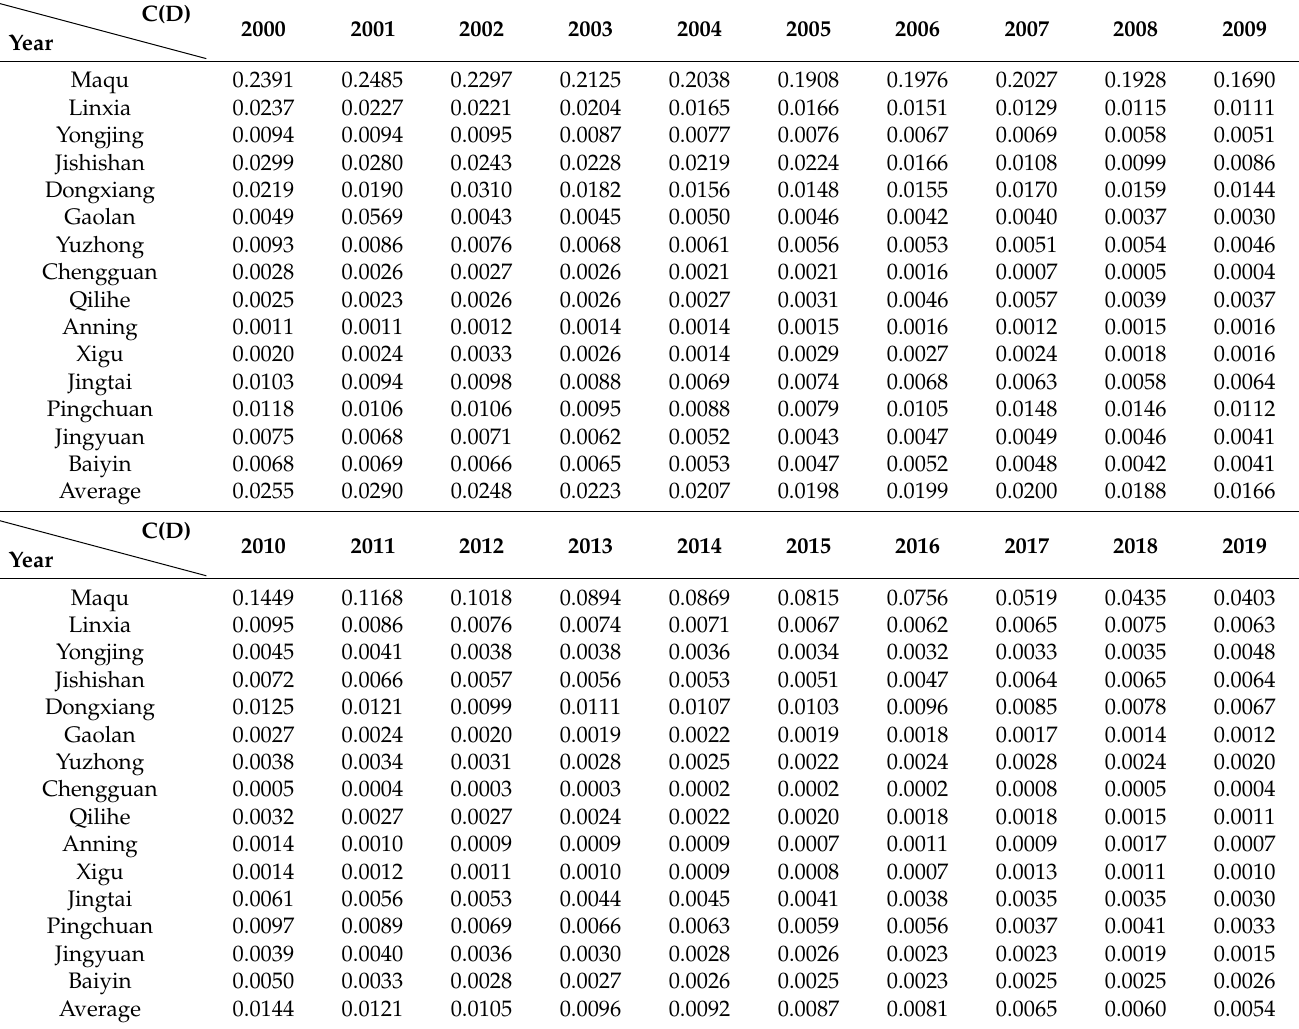
Table 3. The total GHG emissions intensity in the 15 county (district) of Gansu section of the Yellow River Basin from 2000 to